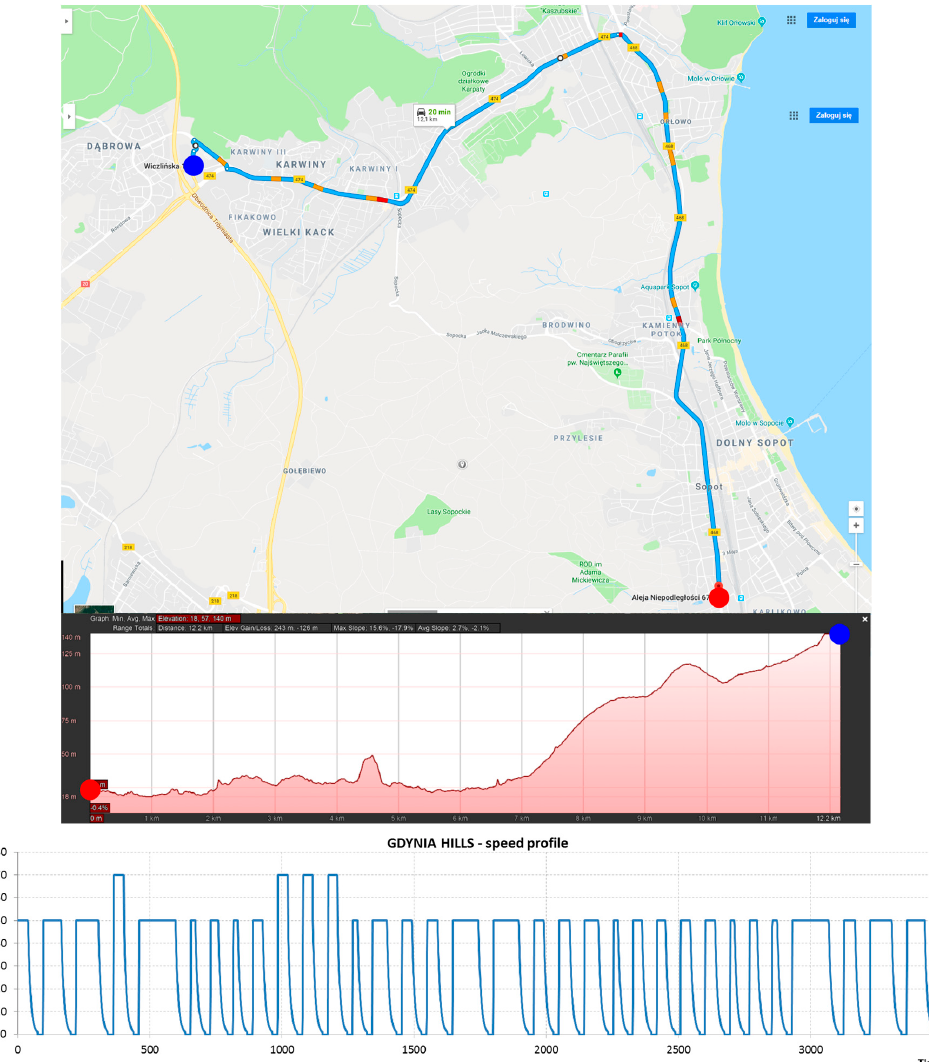
Figure 23. Gdynia-Hills route height and speed profiles. Map data from Google Maps.